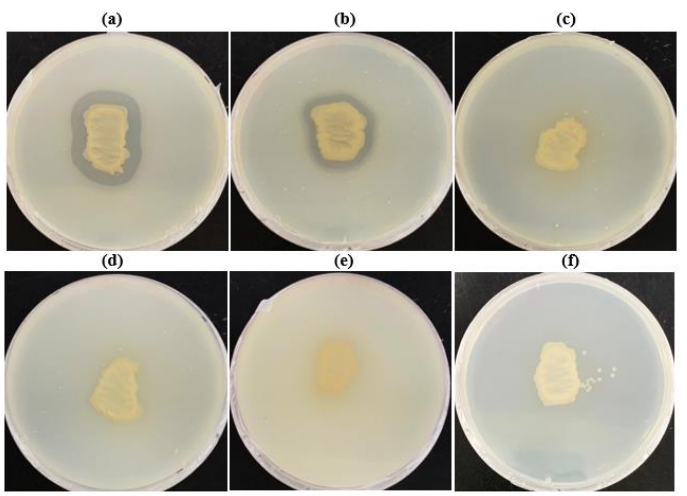
Figure 5. Biodegradation activity of the Microbulbifer sp. SOL66 cells were applied to other bioplastics. ( a ) Poly(3-hydroxybutyrate-co-4-hydroxybutyrate) [(P(3HB)-co-4HB)], ( b ) poly(3-hydroxybutyrate- co -3-hydroxyvalerate) [P(3HB-HV)], ( c ) polybutylene succinate (PBS), ( d ) polybutylene adipate terephthalate (PBAT), ( e ) polycaprolactone (PCL), ( f ) polylactic acid (PLA). The cell was cultured on the plates containing bioplastic emulsion, and the formation of the clear zone was observed.